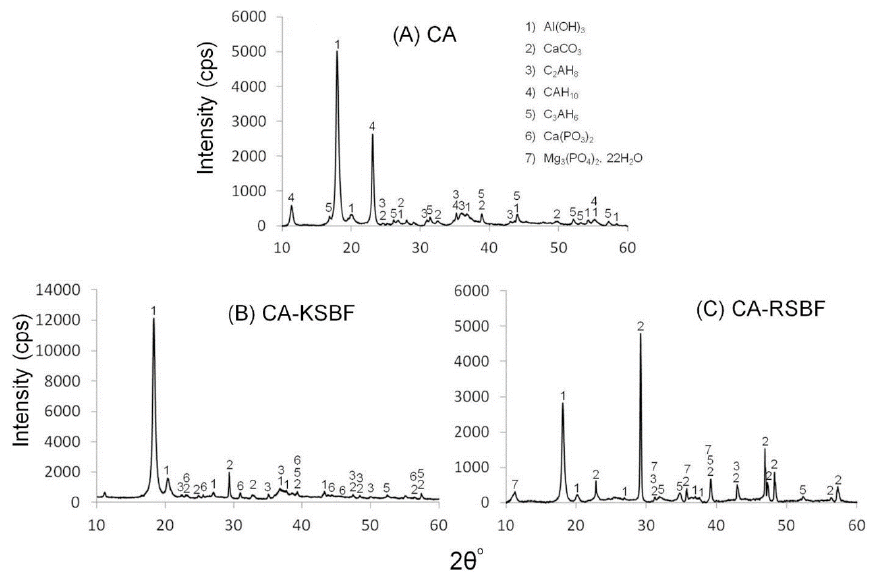
Figure 5. XRD patterns of CA (A) before immersion in SBF; (B) after 7 days in KSBF and (C) after 7 days in